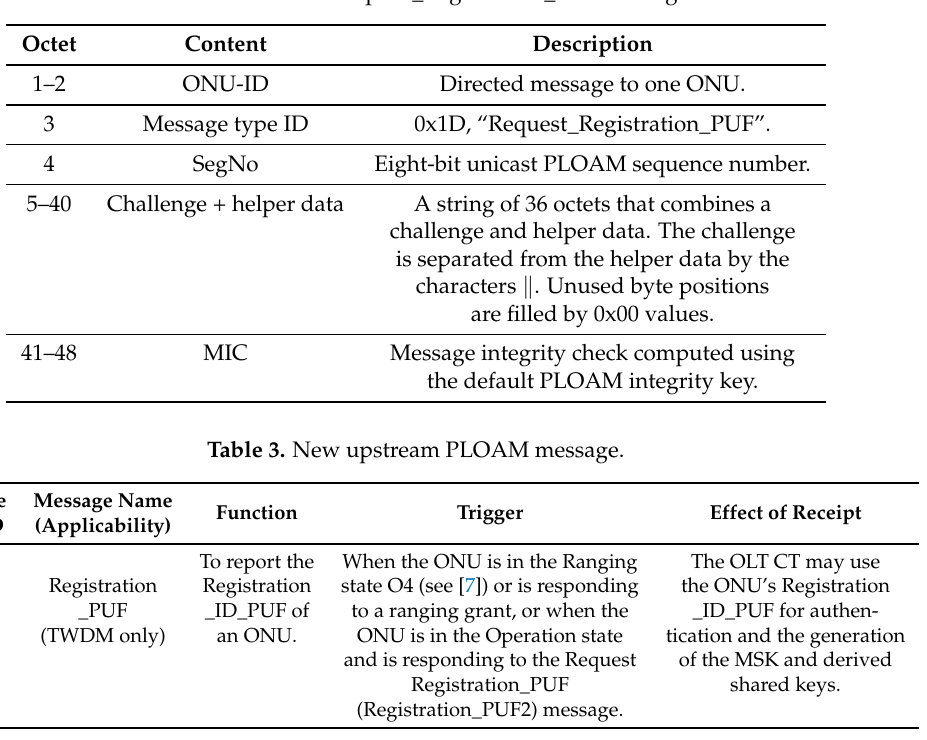
Table 2. Content of Request_Registration_PUF message.